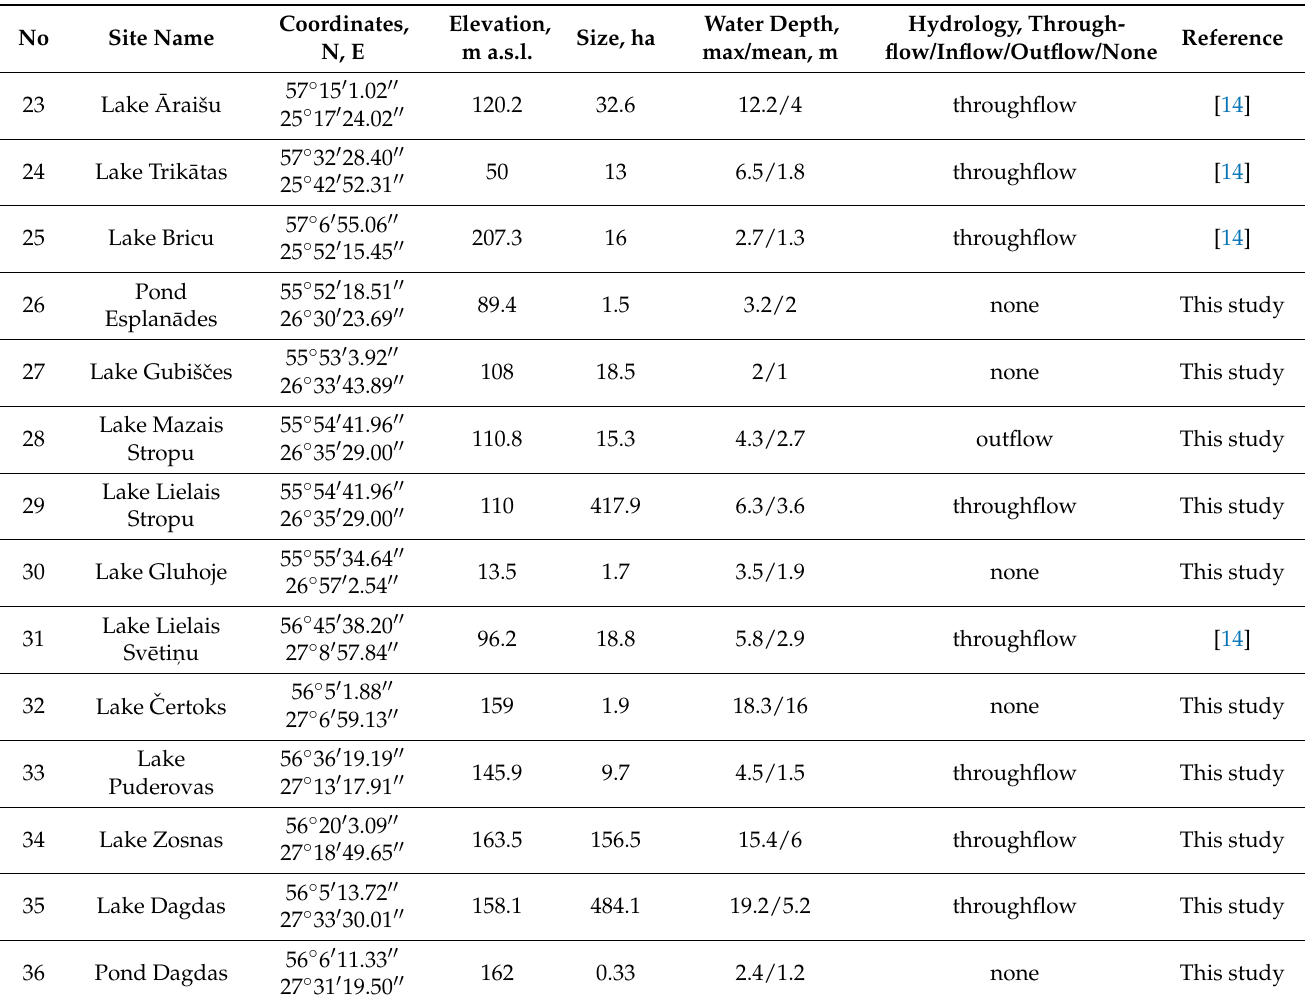
Table 2. Study sites and related